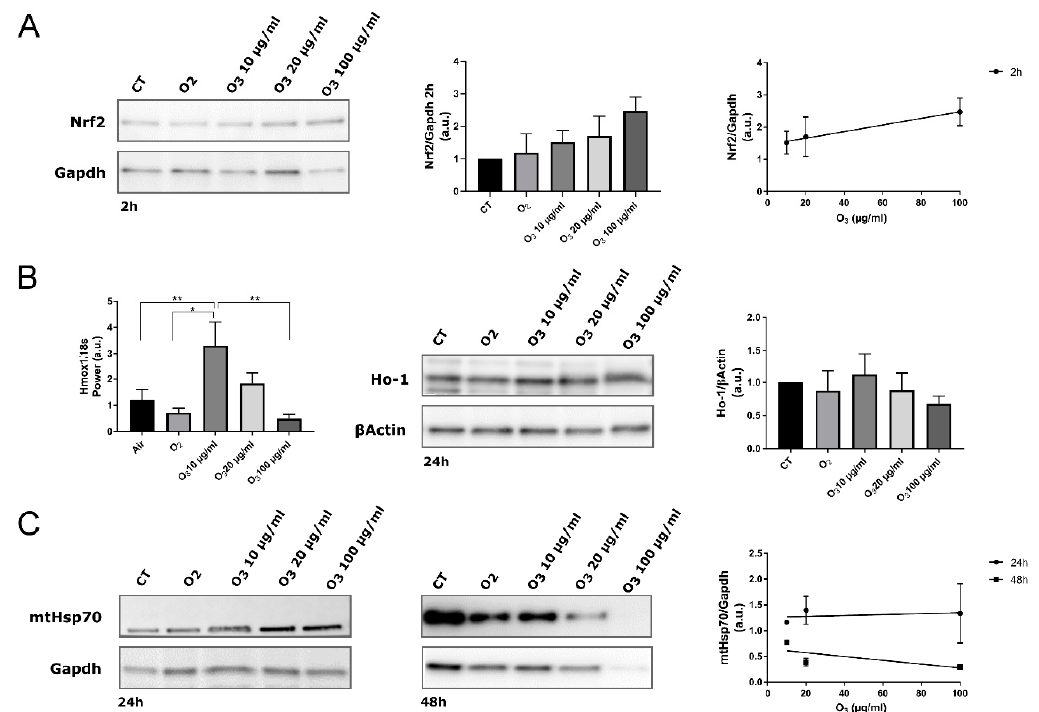
Figure 4. Biomolecular analysis of Nrf2, Hmox1 / Ho-1 and mtHsp70 in control (CT), O 2 -, 10 µ g O 3 -, 20 µ g O 3 - and 100 µ g O 3 -treated AT samples. ( A ) Western blot of Nrf2 protein. Nrf2 stabilization was observed 2 h after O 3 treatment (Western blot and histogram). The protein level is proportional to the O 3 concentration (linear regression p = 0.05; right). ( B ) Gene expression of Hmox-1 in AT at 4 h post-treatment (* p < 0.05, ** p < 0.005; left). The maximum level of Hmox1 expression was reached by treating samples with 10 µ g / mL O 3 . The amount of Ho-1 protein was evaluated at 24 h post-treatment (Western blot and histogram; right). ( C ) mtHsp70 protein was evaluated at 24 h and 48 h post-treatment (left). The protein level is not significantly proportional to the O 3 concentration (linear regression 24 h: p = 0.8; 48 h: p = 0.5; right). The values presented are means ± SE of 3 independent experiments. Data were normalized to the level of housekeeping proteins (Gapdh and β Actin) and expressed as in proportion to the levels in control